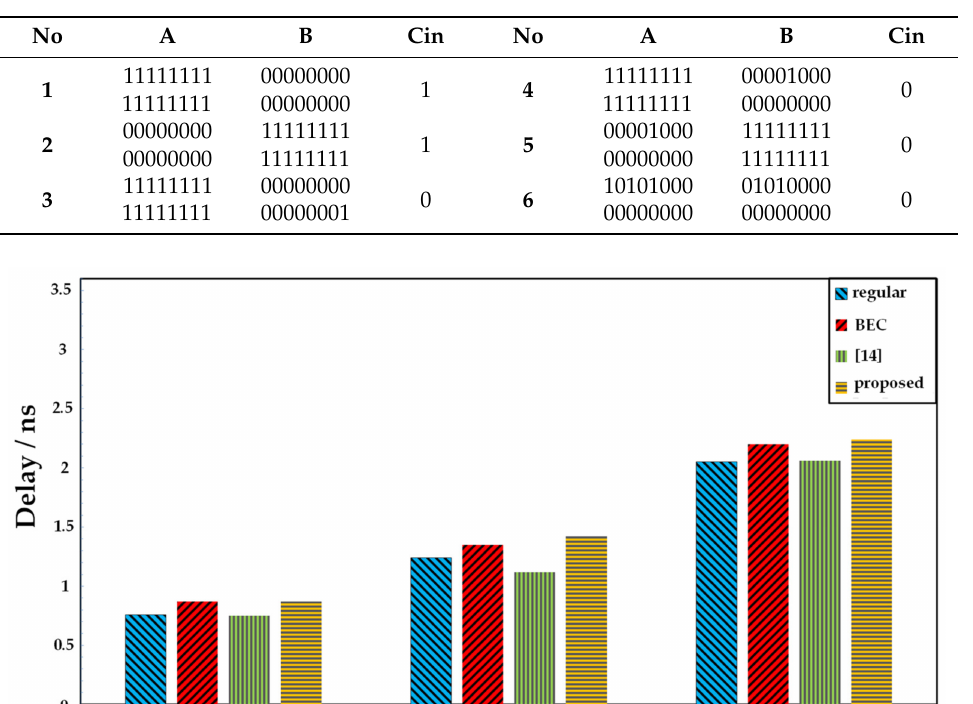
Table 1. Excitations of 16 bit CSLA.